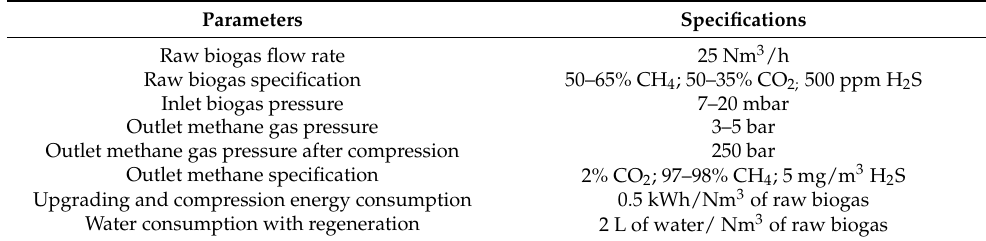
Table 1. Specification of Engas UK’s 25 Nm 3 /h bio-CNG upgrader. Source: Black et al., (2021) [35] and Twinomunuji et al. (2020)